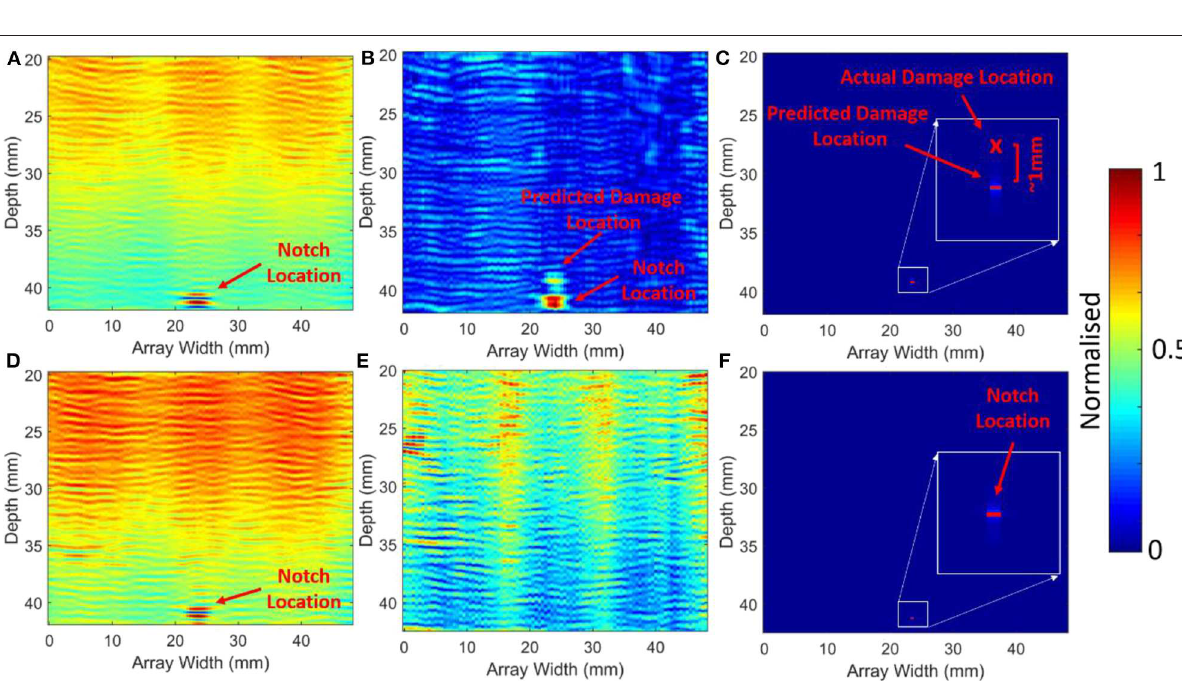
FIGURE 7 | B-Scan of UD fatigue samples using linear and modulated responses: (A) UD aluminum fatigue sample for f 1 ; (B) zoomed region for UD fatigue sample for f